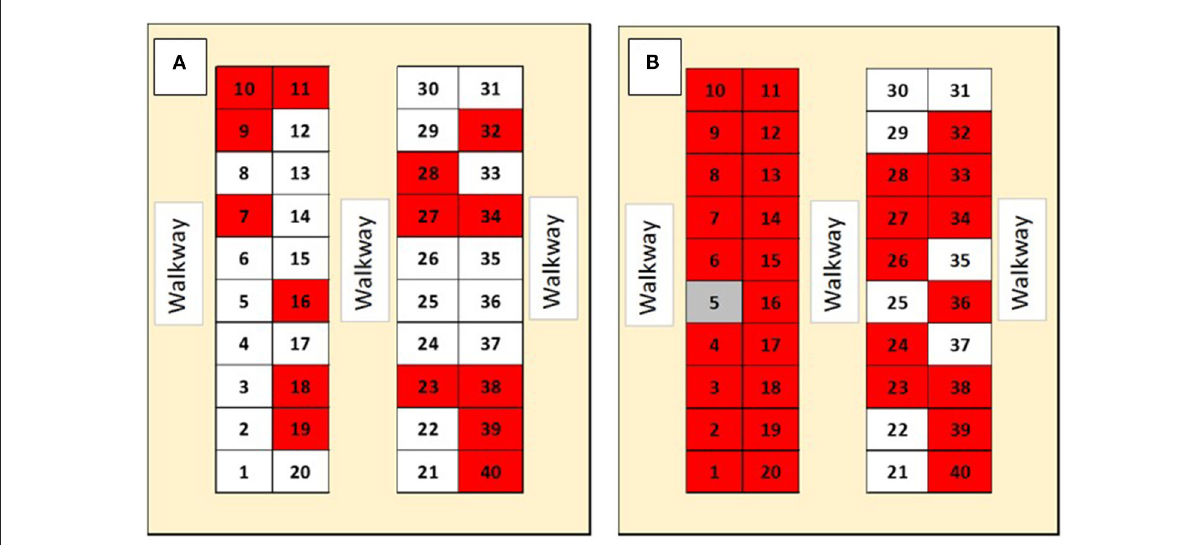
FIGURE4 Prevalence of Atypical porcine pestivirus (APPV) RNAemia in serum samples pooled by pen in an isolation nursery facility. Numbers within figure illustrate pen location within each of two identical nursery facilities located on the same premise. The diagram on the left (A) is from sampling on 8/20/2020, while the diagram on the right (B) is from sampling on 9/30/2020. Gray indicates a suspected detectable APPV RNA, red pen indicates pooled serum with detectable APPV RNA, and white pen indicates no detectable APPV